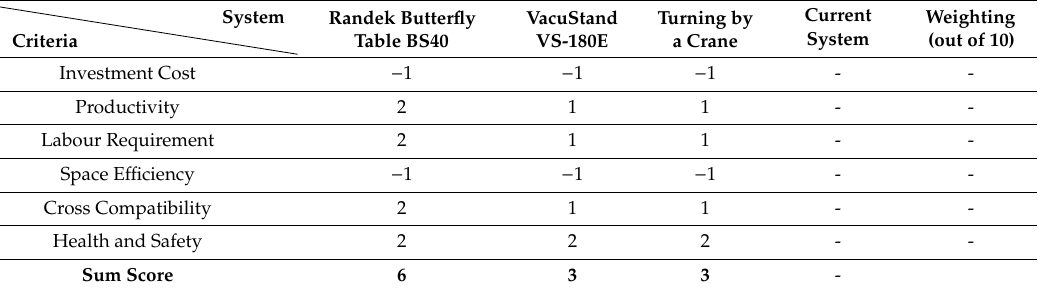
Table 13. Resultant scores for the turning